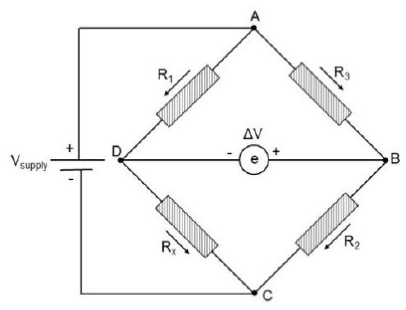
Figure 1. Wheatstone bridge.